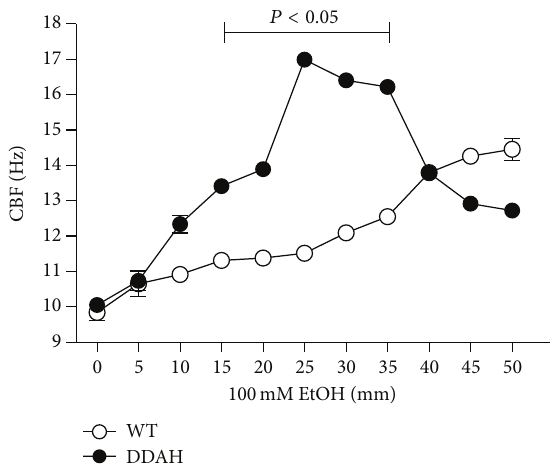
Figure 4: Alcohol stimulation of tracheal epithelial CBF is enhanced in mice expressing an ADMA-degrading enzyme. Tracheal rings from mice overexpressing the ADMA-degrading enzyme dimethylaminohydrolase (DDAH) were treated with 100mM alcohol (EtOH) and their CBF compared to wild type (WT) mice. While the magnitude of maximal alcohol-stimulated CBF increases did not differ between mice, the time to maximal CBF was significantly decreased in the DDAH mice versus WT mice treated with alcohol ( ∗ 𝑃 < 0.05 ). No significant differences in CBF were observed in control, media-incubated tracheal rings. Bars represent SEM of triplicate separate experiments ( 𝑛 = 3 ).